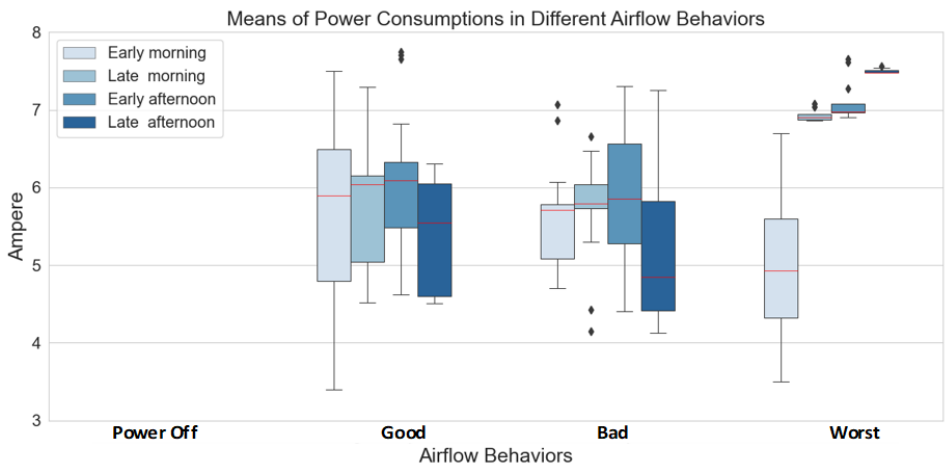
Figure 5. The differences of ampere means and errors conditioned on TimeOfDay and Target .